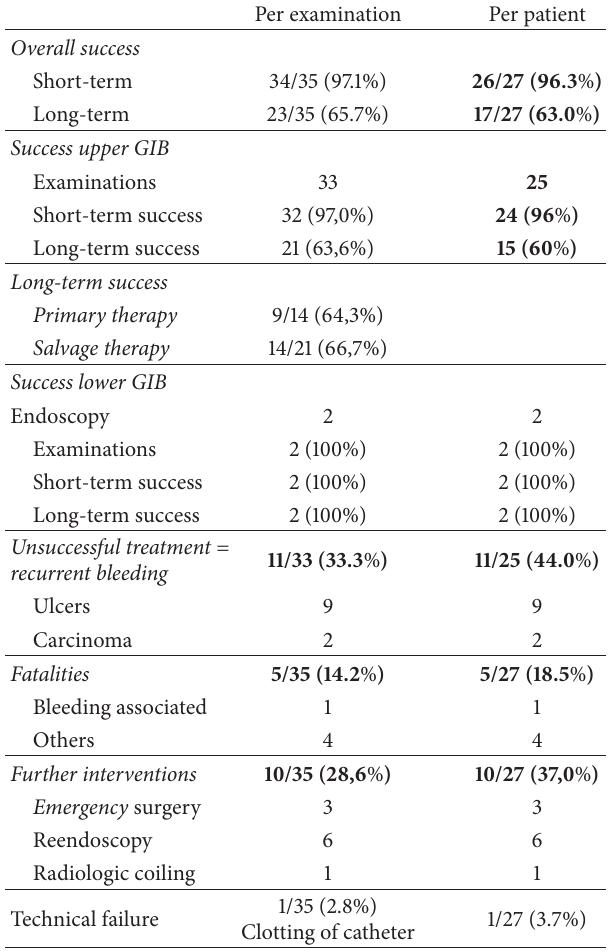
Table 3: Short-term success was defined as successful hemostasis during endoscopy persisting for at least 24 hours. Long-term success was defined as no further bleeding from the treated bleeding source within 30 days. One patient died during EE due to an aortoesophageal fistula. Three more patients died due to septic multiorganic failure during the hospital stay; one patient died due to liver failure following cirrhosis. These four fatalities were not linked to emergency